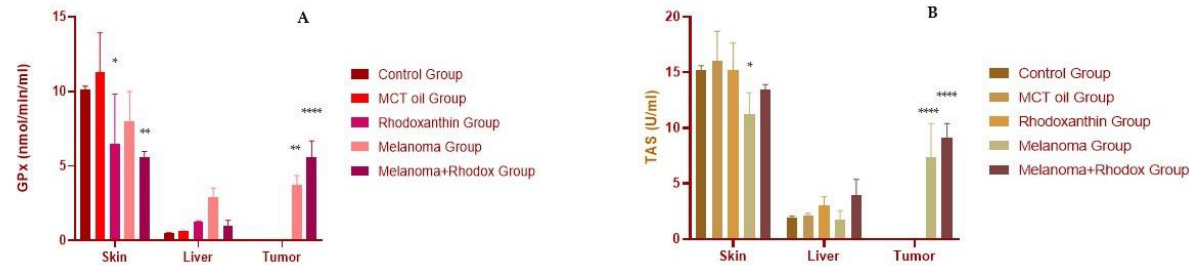
Figure 7. Enzymatic antioxidant activity of glutathione-peroxidase ( A ) and the total antioxidant status ( B ) in tissues. Values are expressed as mean ± standard deviation SD from three independent experiments. Statistical significance level * p < 0.05, ** p < 0.01, and **** p < 0.0001.